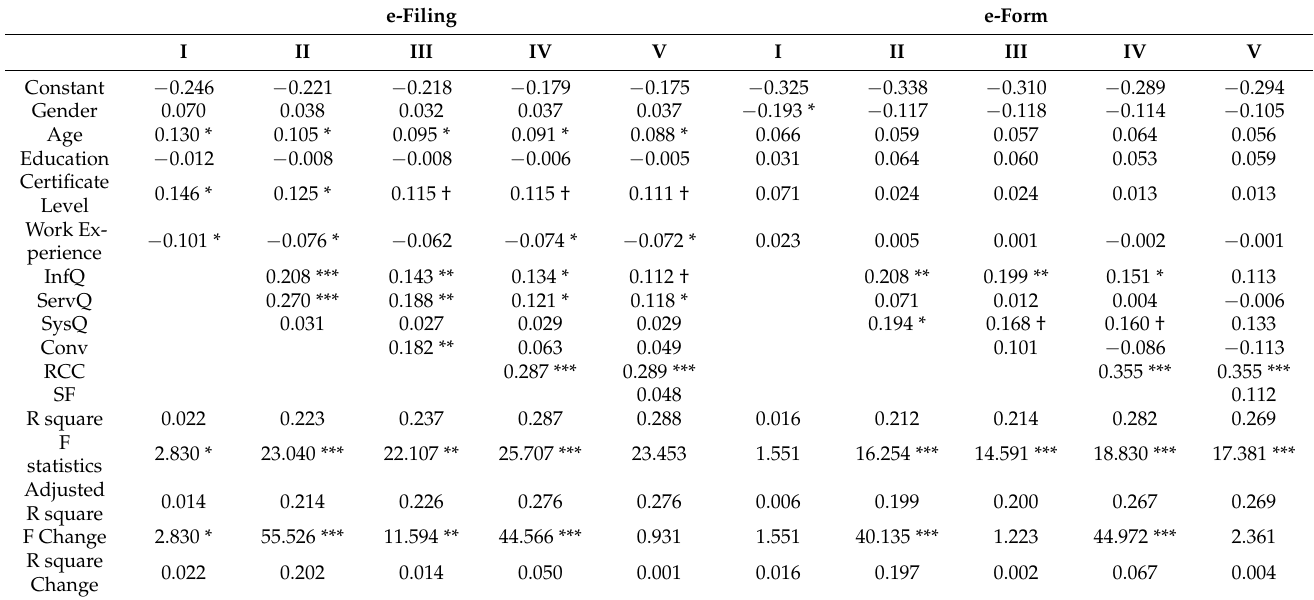
Table 7. Comparative hierarchical regression results between e-Filing and e-Form services.